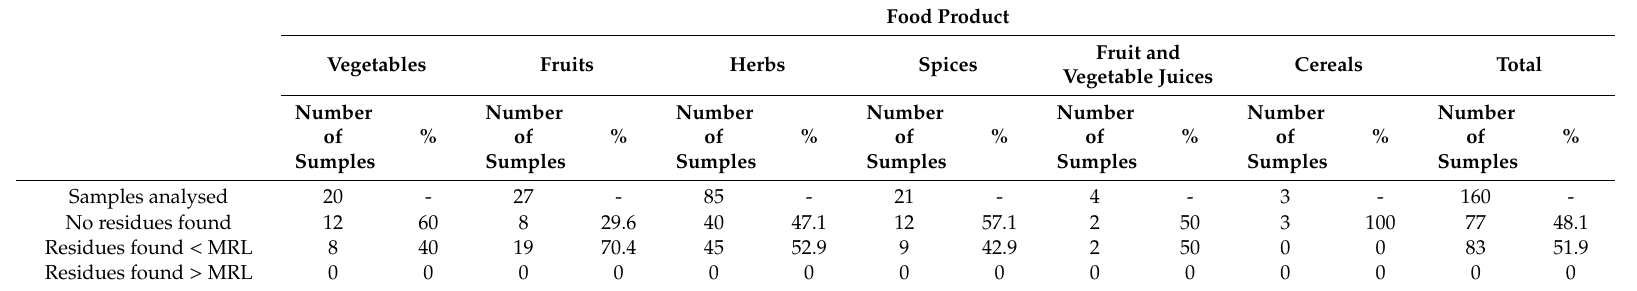
Table 1. Number of samples with and without detected pesticides residues for each analysed food